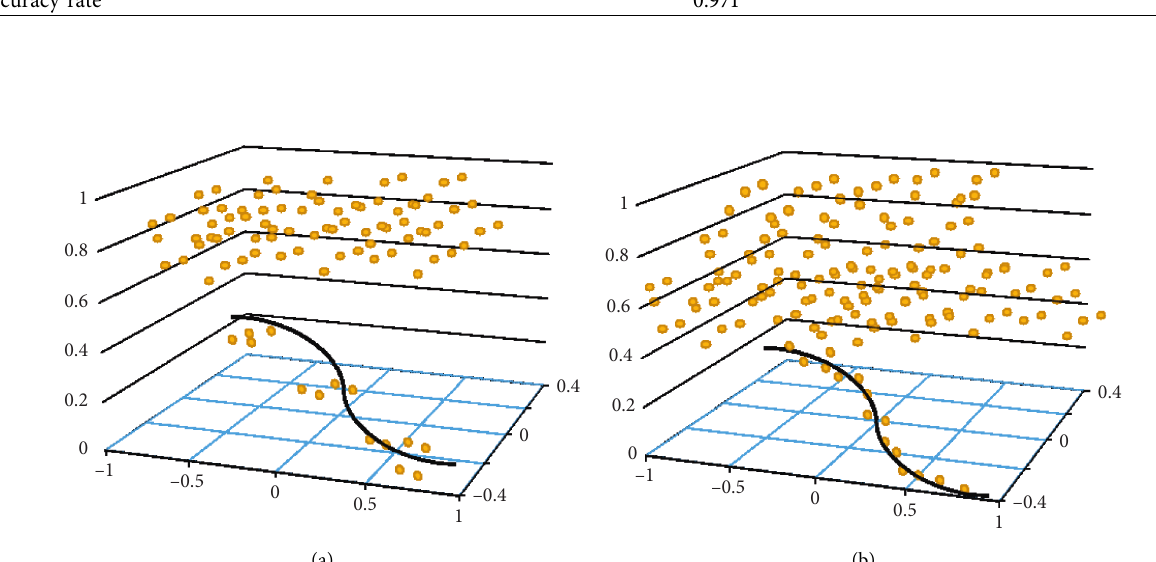
Figure 8: 3D sparse data. (a) 3D data obtained from wrong feature points and (b) 3D data obtained from correct feature points.